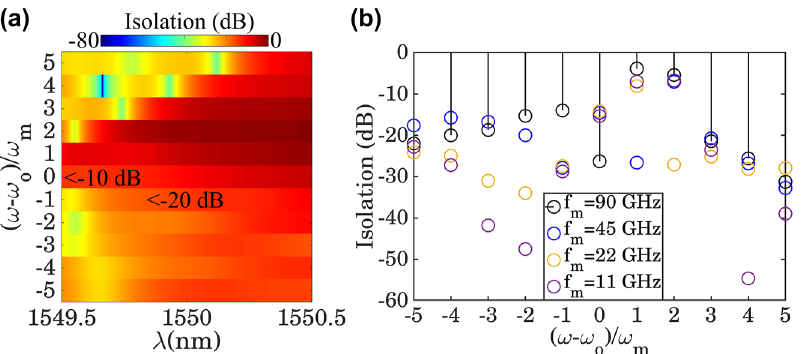
Figure 6: Tunable optical nonreciprocity. (a) The calculated optical power isolation between the existing higher-order harmonics dwelling at + 𝜔 , as a function of the operating wavelength. On account of the filtering behavior of the static layer, changing port 1 with respect to 𝜔 m o the operating wavelength will affect the isolation level from 0 to − 80 dB. (b) The dependency of the power isolation between 𝜔 𝜔 + 𝜔 on the modulation frequency, when the operating wavelength is fixed to 𝜆 m o